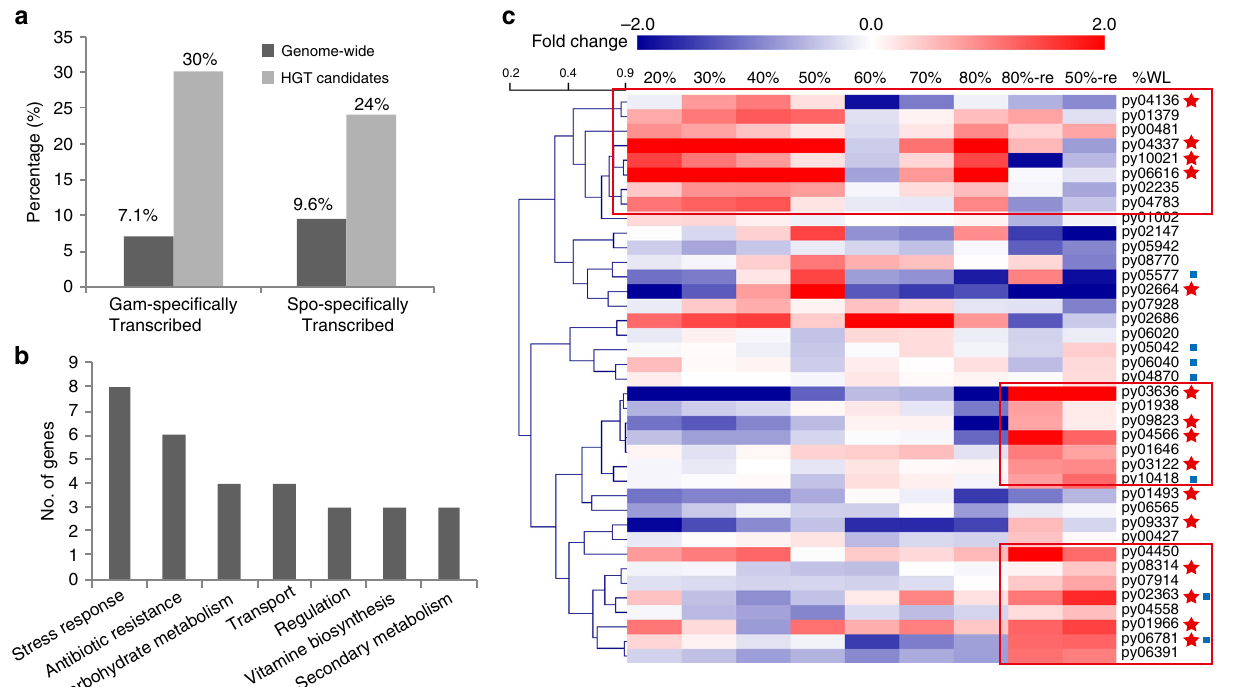
Fig. 5 HGT candidates identi fi ed in the P. yezoensis nuclear genome. a The percentage of differentially expressed gam-speci fi cally transcribed and spo- speci fi cally transcribed genes that are HGT candidates when compared to overall gene expression values. b Functional categorization of HGT candidates. Biological functions were de fi ned by the associated Gene Ontology terms in biological process followed by manual curation. c The transcriptional patterns of HGT candidates under dehydration and rehydration stress. Heatmap was made as described in Fig. 2. Gam-speci fi cally transcribed HGT genes are highlighted with red stars and genes involved in stress response are indicated as blue squares. Clusters that exhibited upregulation under dehydration or rehydration are in red